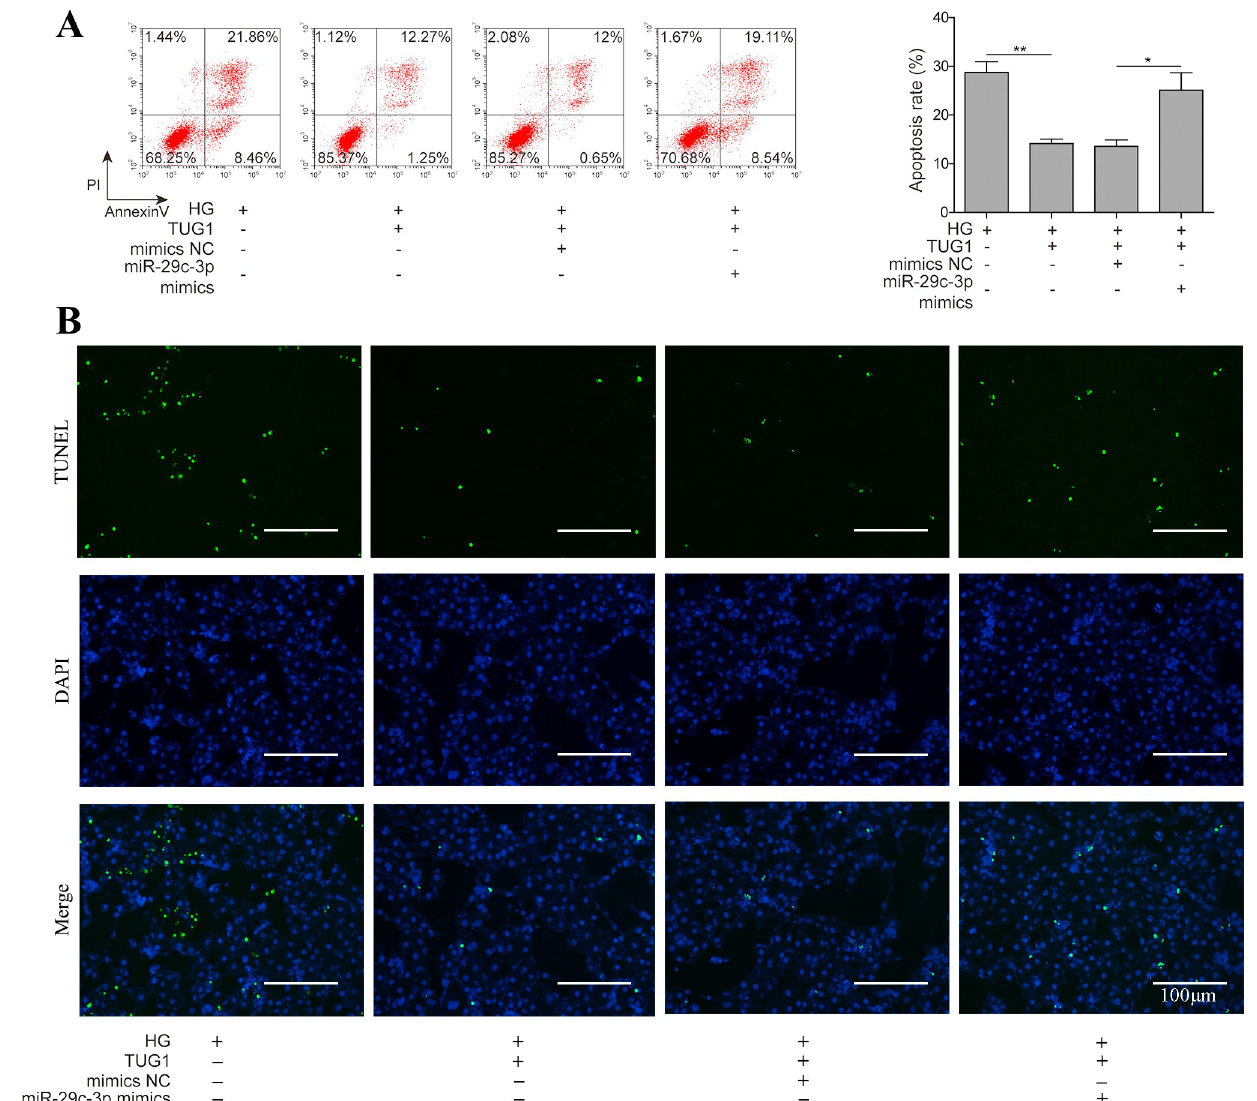
Fig 5. The protective role of TUG1 is dependent on its ability to downregulate miR-29c-3p expression. (A, B) HK-2 cells were transfected with TUG1, either alone or in combination with miR-29c-3p mimics, followed by D-glucose treatment for 48 h, cell apoptosis was evaluated by TUNEL staining and flow